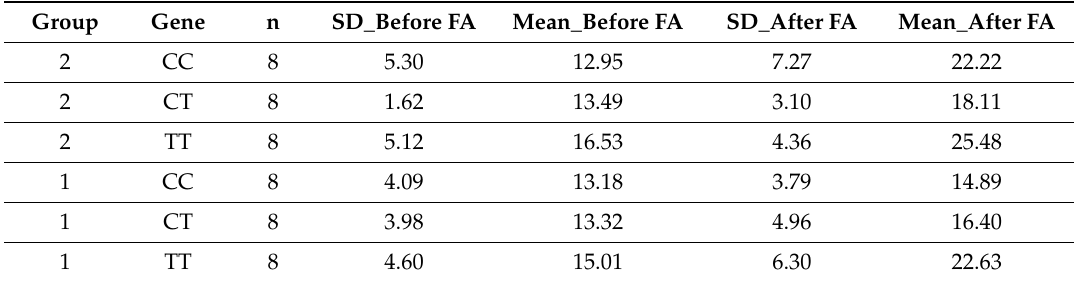
Table 2. Analysis of the mean and standard